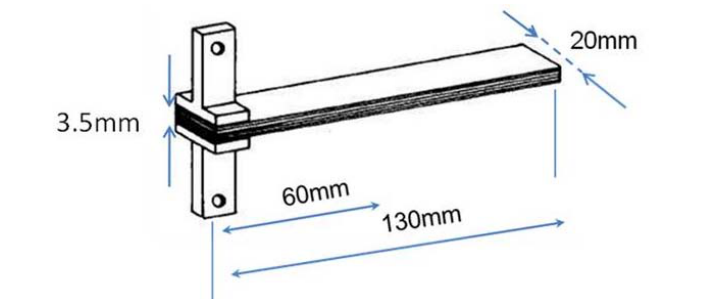
Figure 12. Sample geometry for double cantilever beam (DCB) fracture toughness